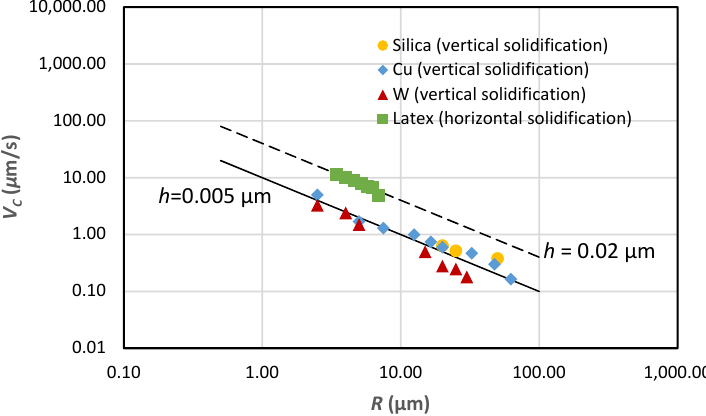
Figure 6. Critical growth rate, V C , vs. particle radius, R , in distilled water solidified vertically or horizontally. Equation (25) is used to calculate the dash line assuming h = 0.02 µ m and the solid line assuming h = 0.005 µ m. The solid markers are experimental data from literature. • Silica (vertical solidification) [27], (cid:7) Cu (vertical solidification) [27], (cid:78) W (vertical solidification) [27], and (cid:4) (horizontal solidification)